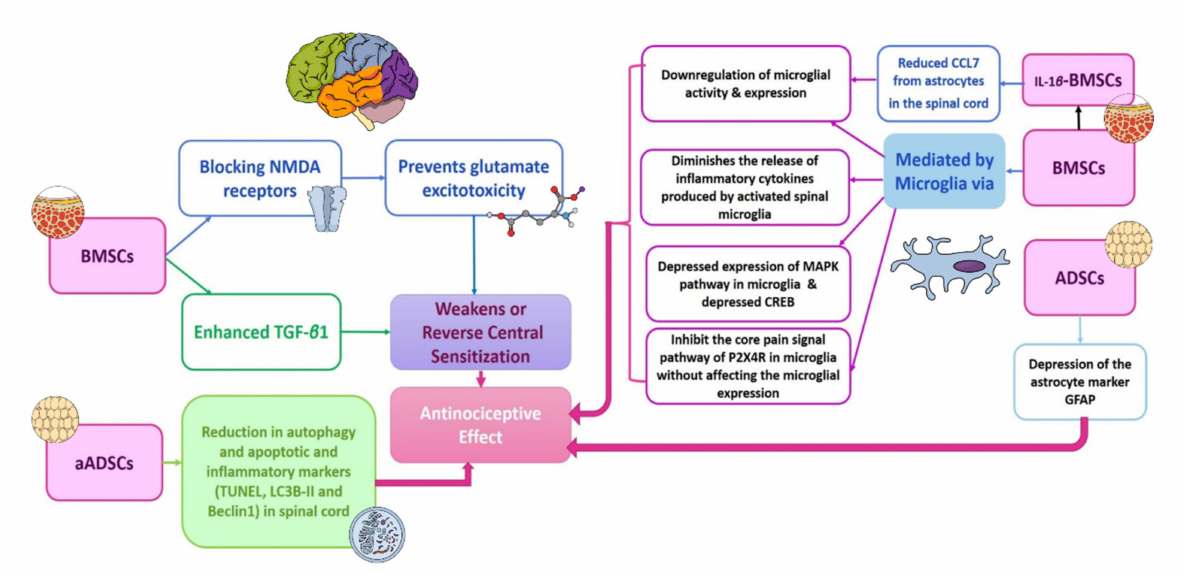
Figure 4. Proposed mechanisms for central NP alleviation via different types of stem cell therapy. Based on previous research, there are three main mechanisms for the antinociceptive effects of stem cell therapy. These mechanisms encompass the modulation of the glial cells (microglia and astrocytes) functions, weakening or reversal of central sensitization and reduction in autophagy, apoptosis and inflammatory markers in the spinal cord. Each of these main mechanisms are mediated via different ways according to the type of stem cells investigated. It is obvious that BMSCs act via different mechanisms to induce the analgesic effect. Additionally, conditioning of the BMSCs via IL-1 β adds to these mechanisms. The ADSCs act mainly via depressing the astrocyte markers. Moreover,